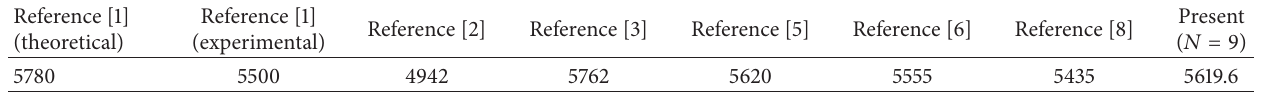
Table 1: Comparison of critical speed (rpm) for composite shaft.